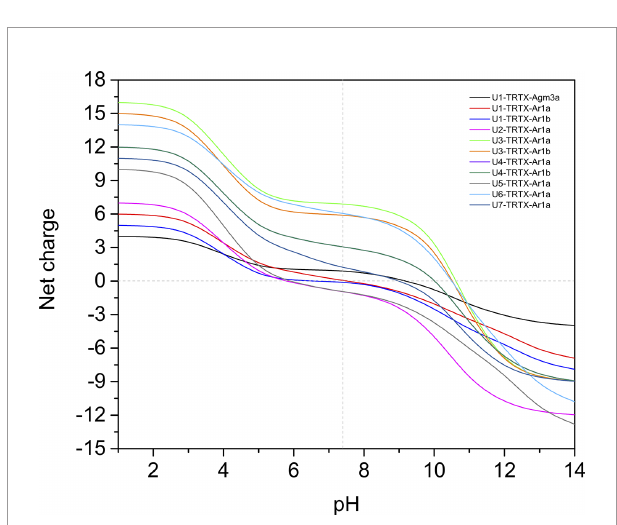
FIGURE 4 | Net-charge analysis of all CRPs validated in Acanthoscurria rondoniae peptidomic venom fraction. Net charges were calculated in pH ranges of 0-14 in 0.5